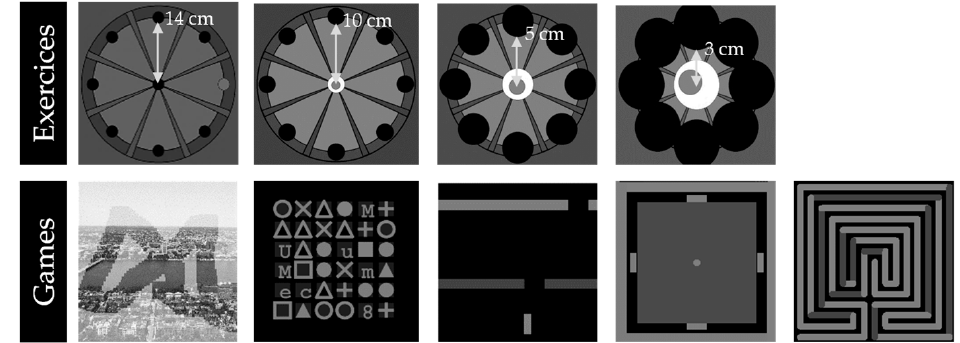
Figure 2. User interfaces for exercises used in Phase 2 and games used in Phase 1.